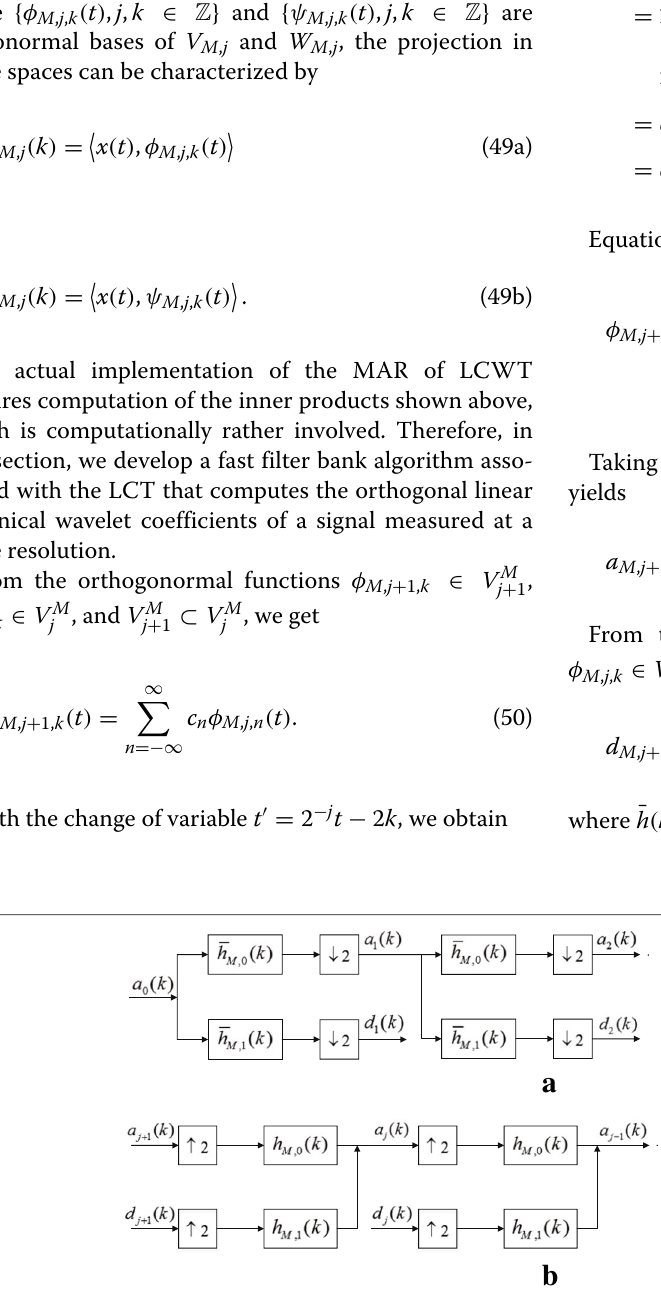
Fig.4 Filter-bank interpretation of the fast algorithm we proposed. a A fast linear canonical wavelet transform is computed with a cascade of filtering with ¯ h M ,0 ( k ) and ¯ h M ,1 ( k ) in the LCT domain followed by a factor 2 subsampling. Note that the linear canonical convolution is used here according to (53a) and (53b). b A fast inverse linear canonical wavelet transform reconstructs progressively each a M , j by inserting zeroes between samples of a M , j + 1 and d M , j + 1 , filtering in the LCT domain and adding the outputs. Note that the linear canonical convolution is used here according to